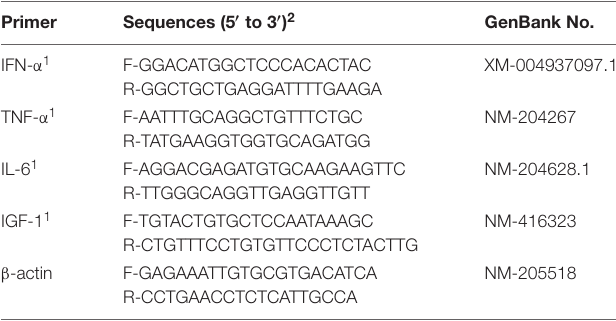
TABLE 2 | Primer sequences used for real-time PCR and the GenBank number of the PCR products.